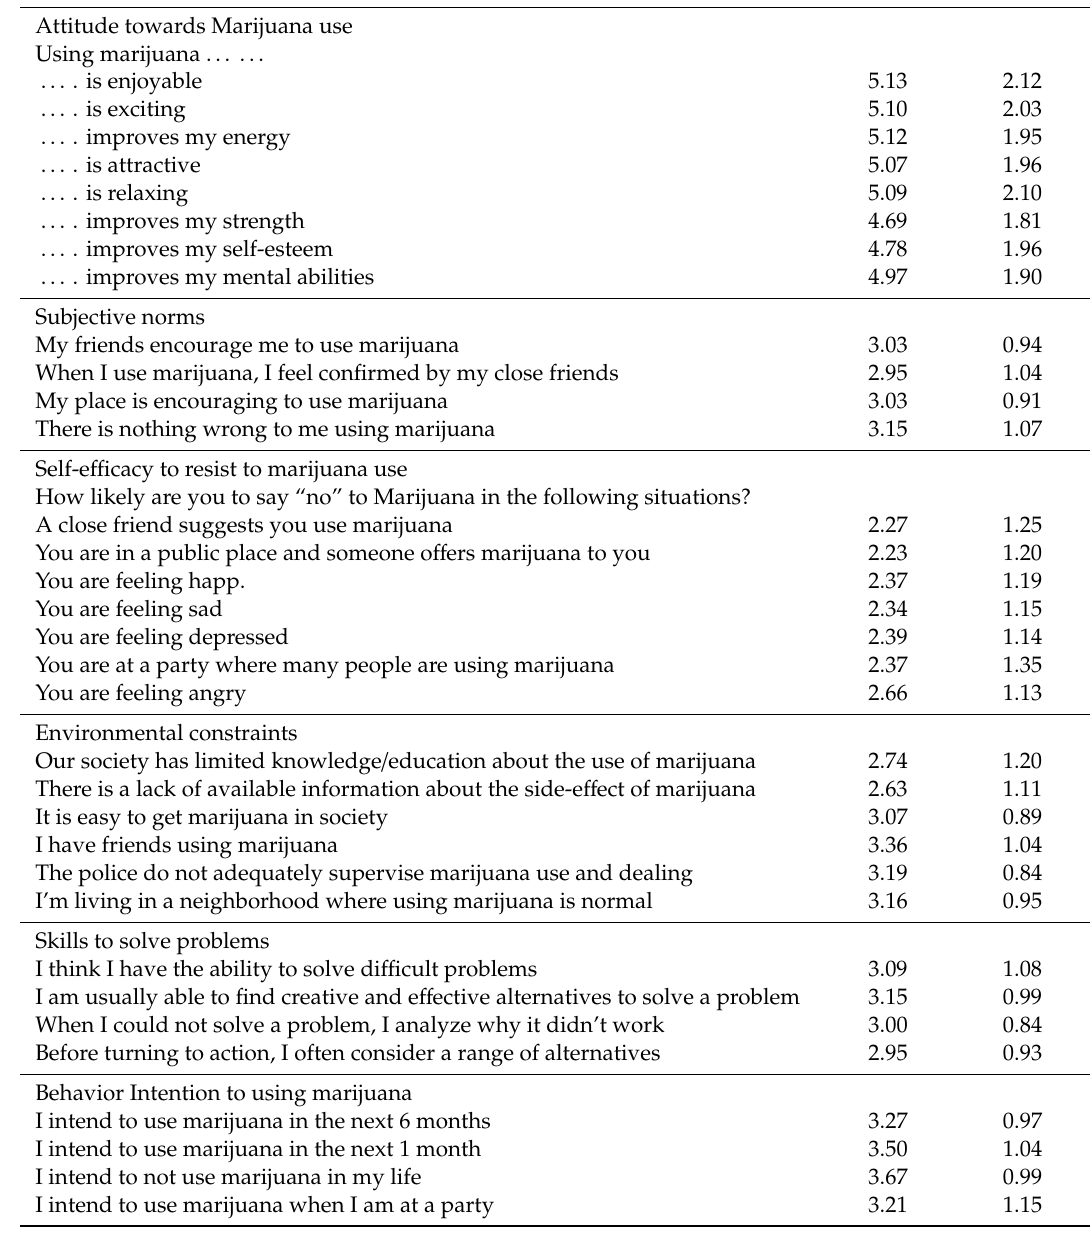
Table 2. Dimensions and descriptive statistical indices of the Theory of Planned Behavior.